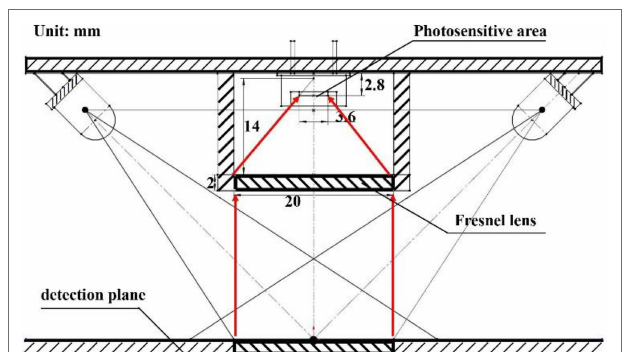
FIGURE 9 | Spectral acquisition unit